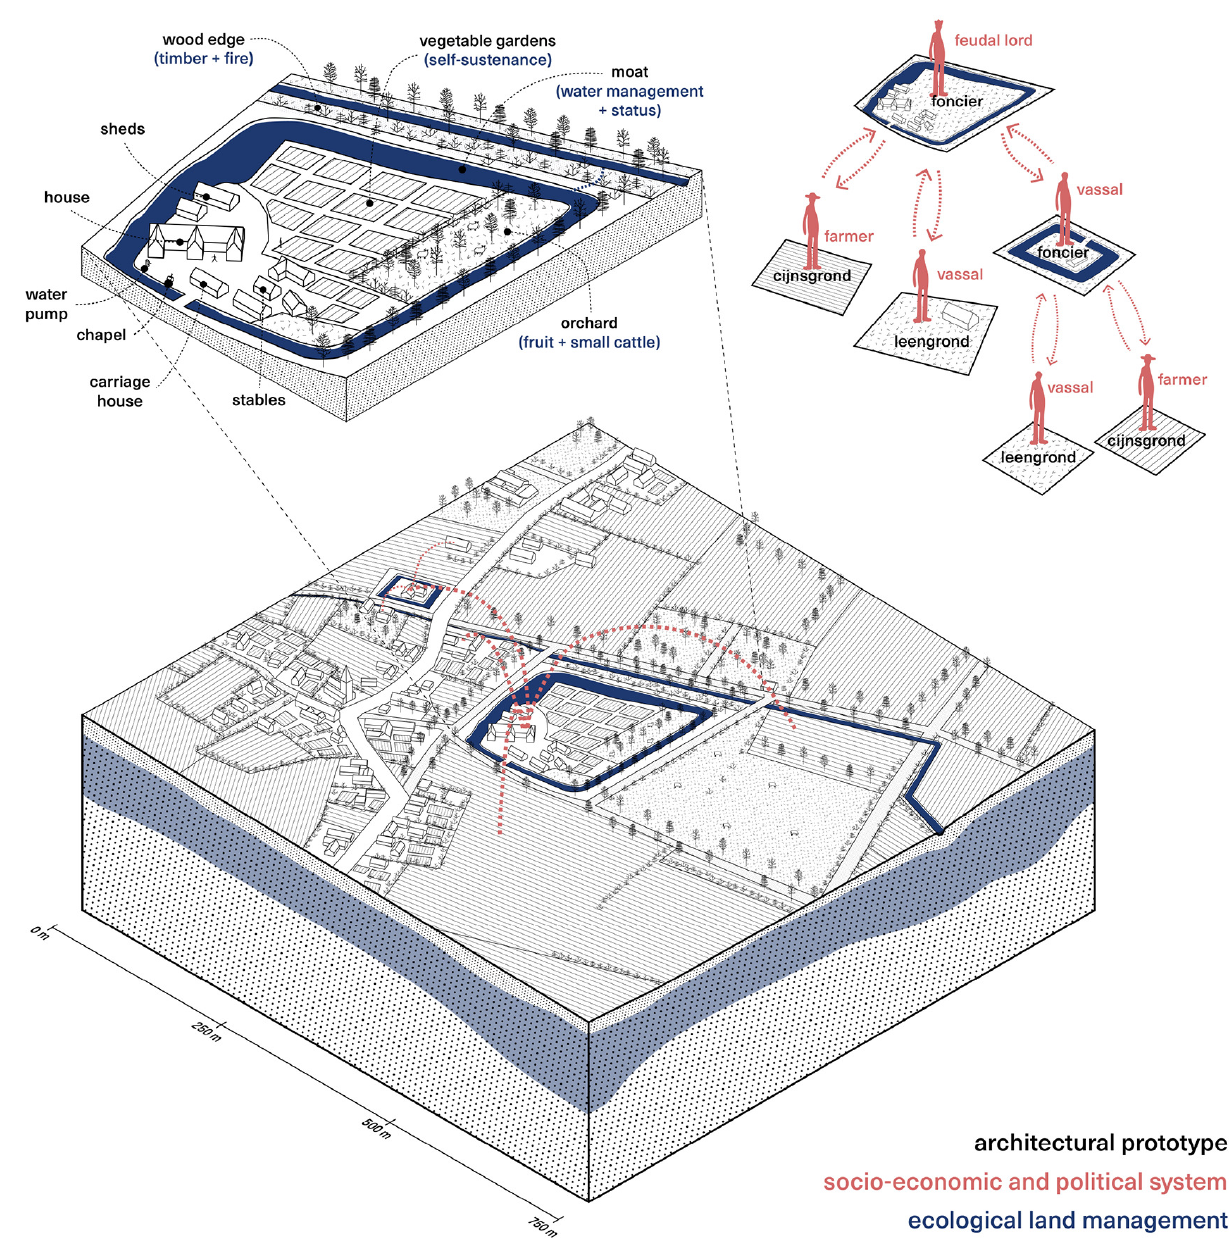
Figure 7. The moated farmstead Goed te Mouden in Moen, South‐West Flanders can be considered an architectural typol‐ ogy, a typical expression of a socio‐economic and political system, and a typology of ecological land management. Source: Sophie Leemans’ based on de Ferraris’ 1771 map (Geopunt Vlaanderen,